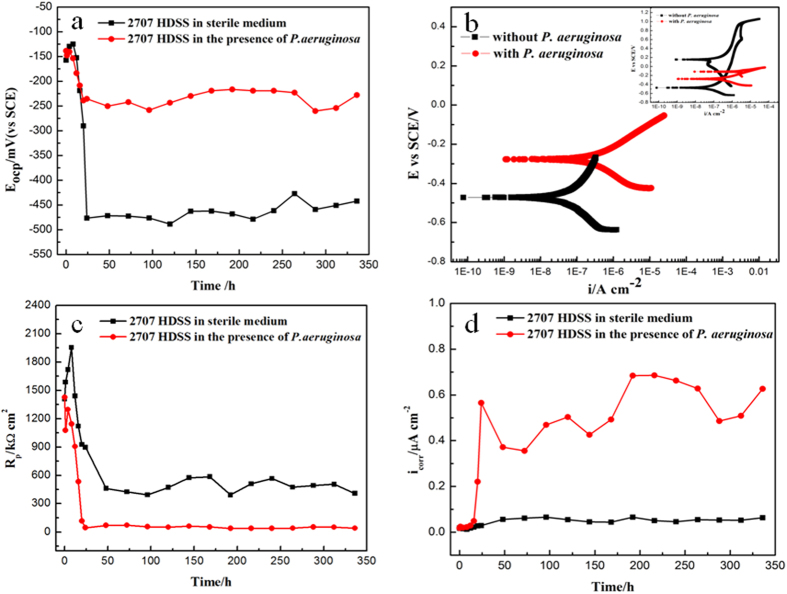
Electrochemical tests for 2707 HDSS coupons in the abiotic medium and in the P. aeruginosa broth at 37 °C:(a) variation of Eocp with exposure time, (b) polarization curves on the 14th day, (c) variation of Rp with exposure time, and (d) variation of icorr with exposure time.